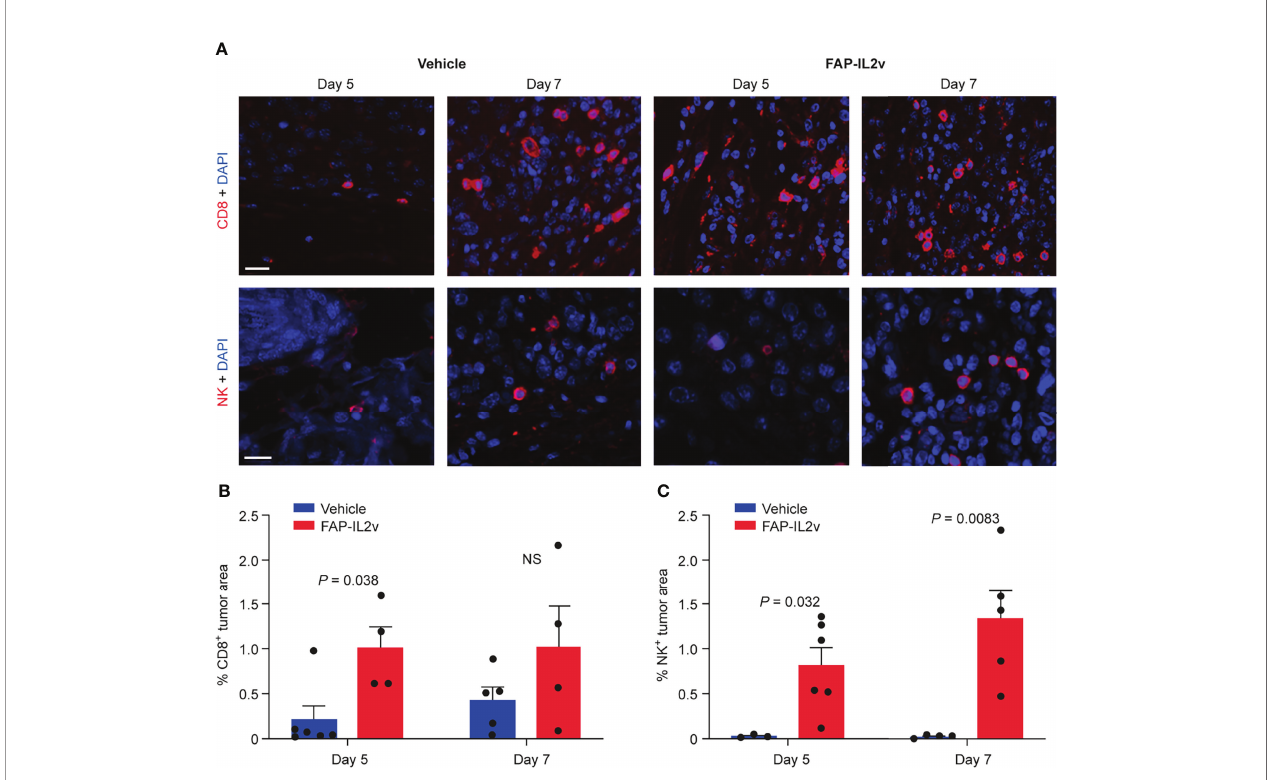
FIGURE 4 | IL-2 variant fused to fi broblast activation protein (FAP-IL2v) treatment increases the number of CD8 + T cells and NK + cells in B16-FAP melanoma tumors. (A) The expression of CD8 + T cells (upper row) and NK + cells (lower row) were visualized in tumor sections 5 and 7 days after baseline imaging in tumors from mice treated with FAP-IL2v and vehicle-treated mice. The scale bar is 20 µm. (B) Quantitative analysis of immuno fl uorescence staining indicates the area of the tumor in fi ltrated by CD8 + T cells ( n = 4-6/group). NS, not signi fi cant. (C) Quantitative analysis of immuno fl uorescence staining indicates the area of the tumor in fi ltrated by NK + cells ( n =